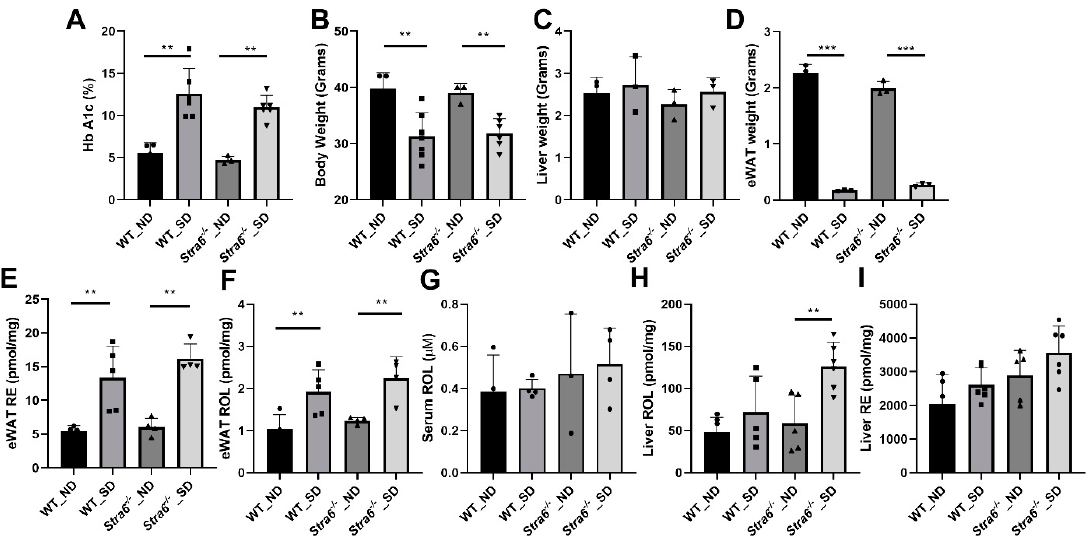
Figure 4. Long-term diabetes alters retinoid metabolism . ( A ) Blood hemoglobin A1c concentrations. ( B ) Bodyweight. ( C ) Liver weight. ( D ) eWAT weight. Serum, liver, and eWAT retinoids